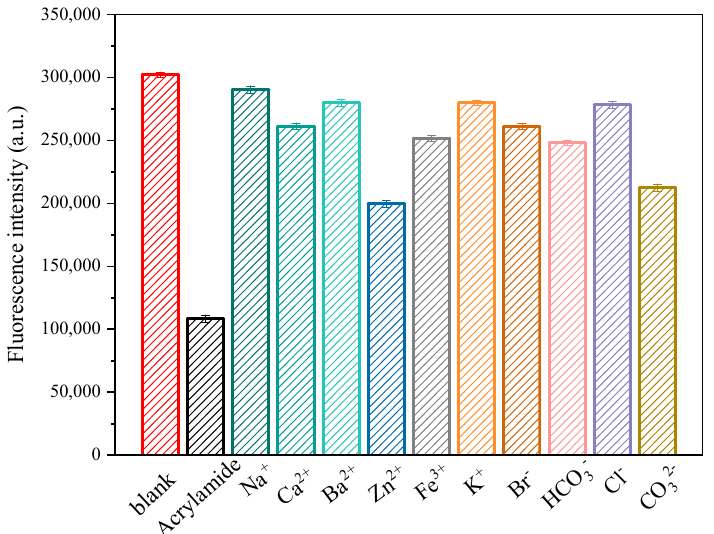
Figure 6. Effect of different ions on the fluorescence intensity of CMC/Eu (III) fluorescent probe at 615 nm.